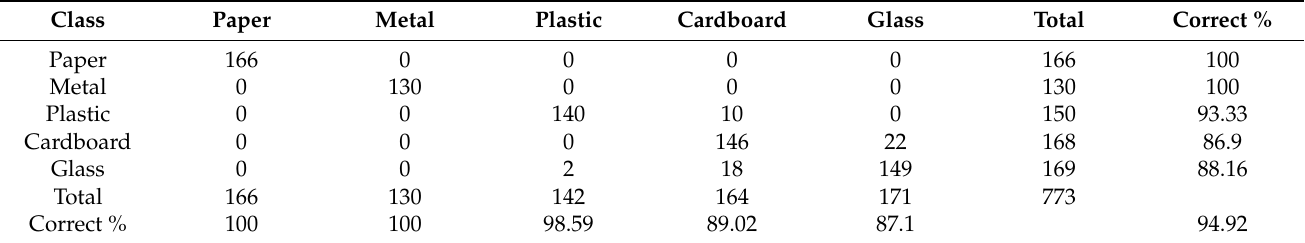
Table 9. Confusion matrix of different waste element segregation using proposed model.